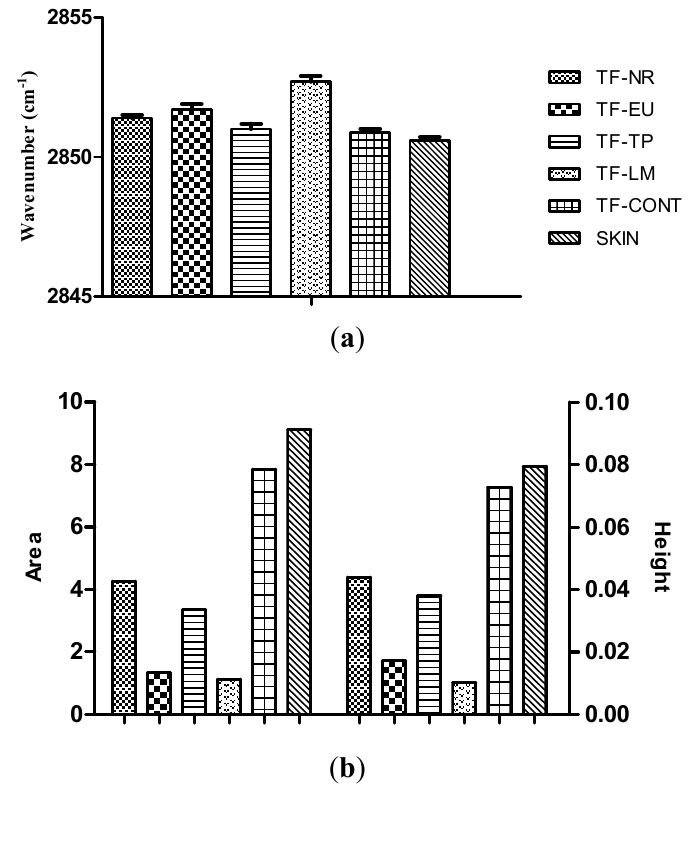
Figure 6. ( a ) Peak positions; ( b ) peak height and areas of skin lipids C–H symmetric absorbances after application of MTC transdermal